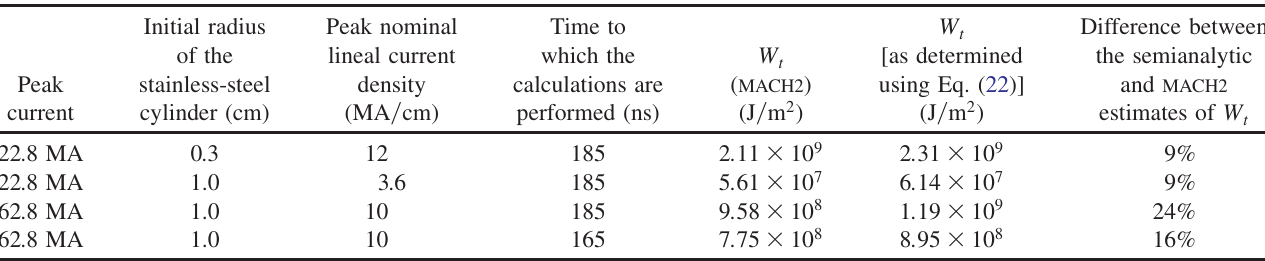
TABLE IV. Summary of conductor-energy-loss calculations performed to quantify the accuracy of the linear-ramp assumption. The 5th column presents results of 1D-Lagrangian MACH2 simulations that use the load-current time history as measured on Z-shot 532 (instead of a linear ramp); this current is plotted by Fig. 9. The 6th column presents energy-loss estimates obtained using Eq. (22) [together with Eqs. (25)–(30) and (D1)] and the current time history plotted by Fig. 9. (The current of Fig. 9 was scaled by a factor of 2.755 for the 62.8-MA calculations.) For the first three cases considered, the calculations were performed until time t ¼ 185 ns (i.e., 20 ns after peak current); for the fourth case, until t ¼ 165 ns (peak current). As suggested by the last two rows, the agreement between Eq. (22) and MACH2 improves at times less than 185 ns (as the pulse shape becomes more like a linear ramp), which is consistent with the results presented by Table I (which assumes an exact linear